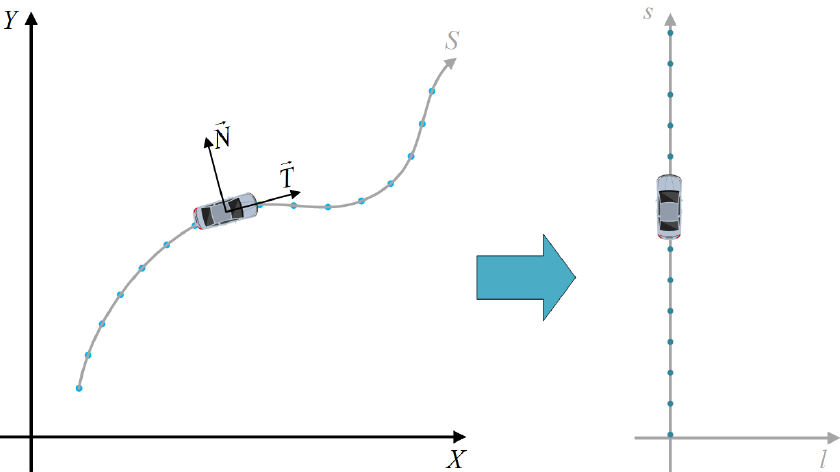
Figure 2. Comparison of the trajectory along the reference line in the Cartesian coordinate system and the Frenet coordinate system.